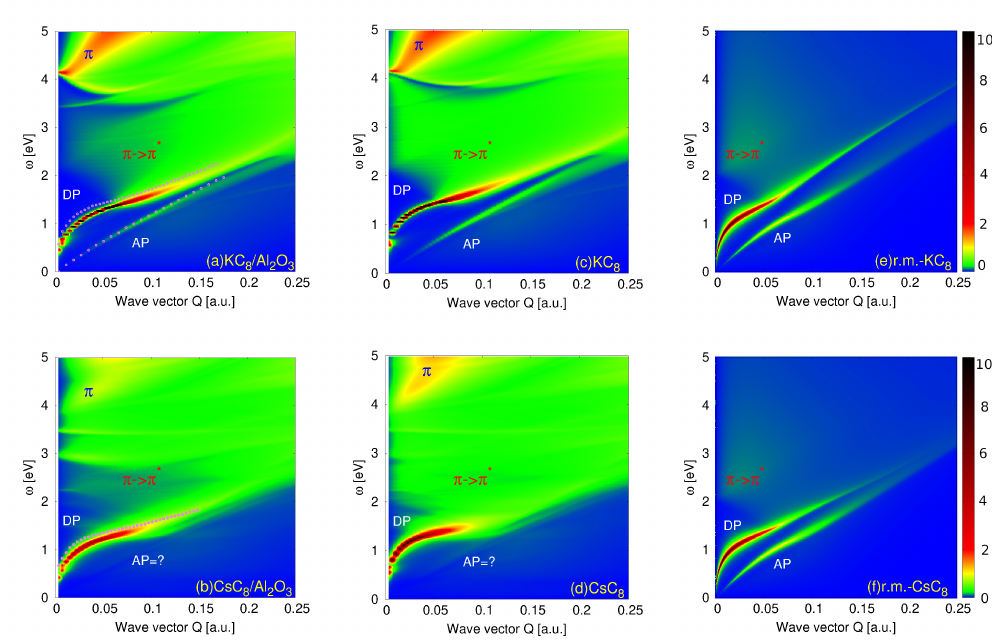
Figure 5. The ab initio spectra of the electronic excitations S ( Q , ω ) in the ( a ) KC 8 and ( b ) CsC 8 deposited on dielectric Al 2 O 3 surface with h = 5.92 Å and h = 6.13 Å respectively (i.e., the separation between the dielectric surface and the alkali atom layer is chosen to be 3 Å ). The ab initio spectra of the electronic excitations in the self-standing ( c ) KC 8 and ( d ) CsC 8 . The magenta dots in ( a , b ) denote the DP and AP dispersion relations in the self-standing samples, i.e., the DP and AP in ( c , d ). The energy loss function −(cid:61){ 1/ (cid:101) ( Q , ω ) } in the self-standing ( e ) KC 8 and ( f ) CsC 8 was obtained using the reduced